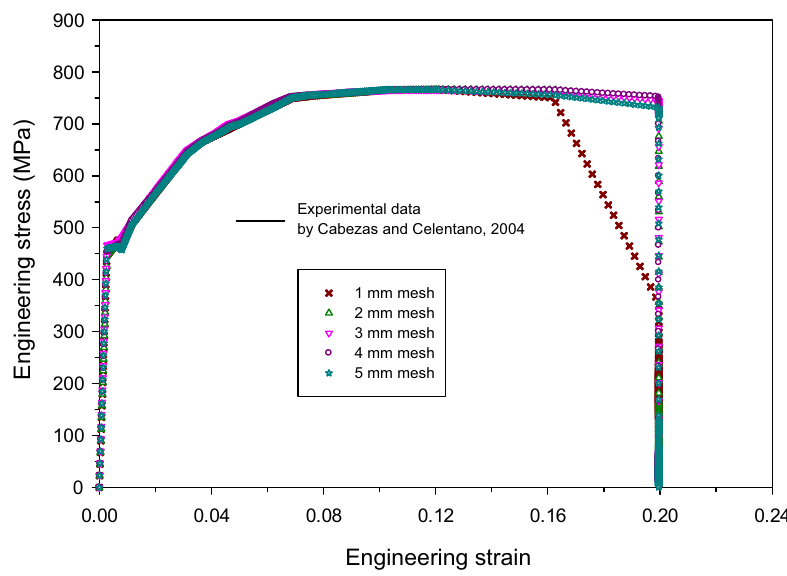
Figure 5: Comparison of the engineering stress engineering versus strain between experimental data [ 17 ] and fi nite element method.